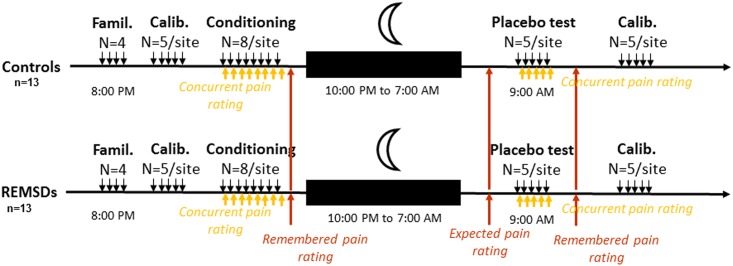
Time course of experimental events: Stimuli were administered in four separate experimental blocks: familiarization, calibration, conditioning, and testing.Treatment (clonidine for REMSDs (n = 13) or placebo for control pill group (n = 13)) was given immediately before going to bed. Famil: familiarization, Calib: calibration.